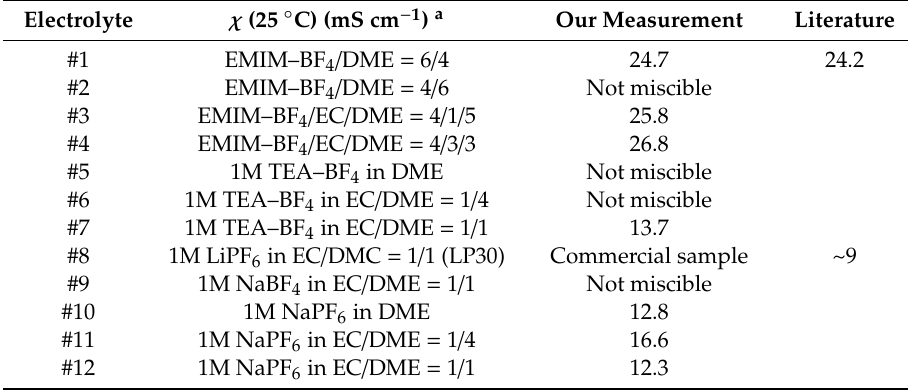
Table 4. Conductivity of the electrolyte formulations designed in this